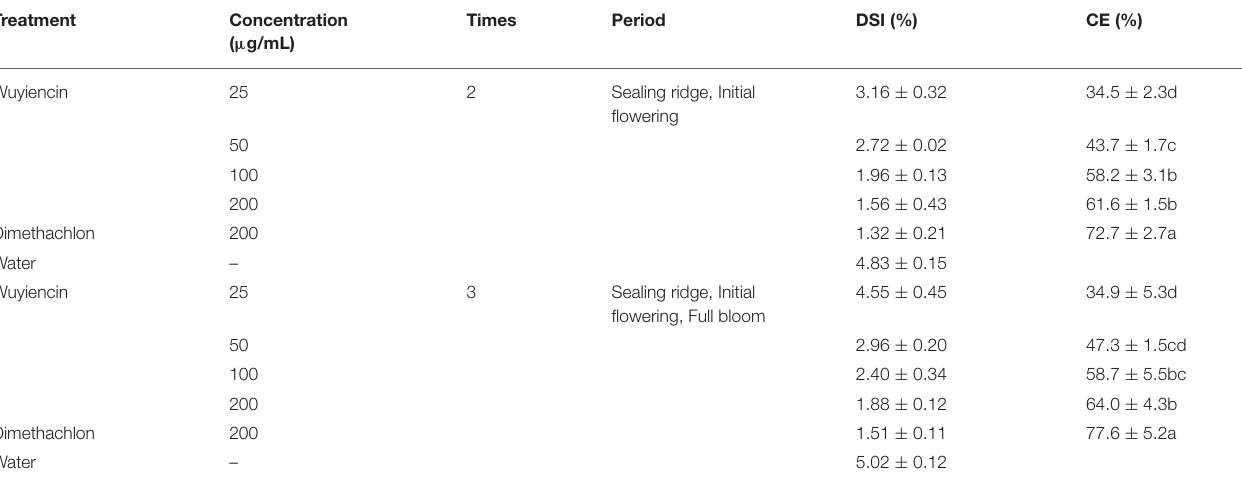
TABLE 6 | Protection effect of wuyiencin against sclerotinia stem rot in the field. Treatment Concentration ( µ